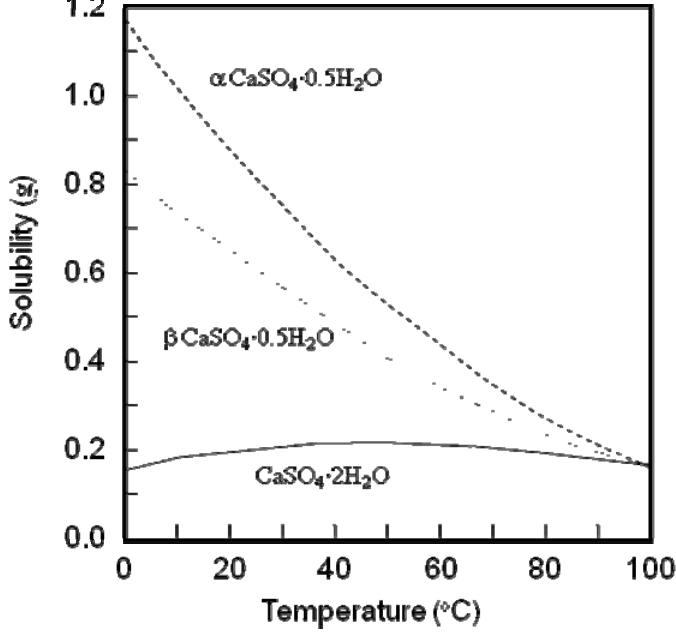
Figure 2. Solubility of α and β calcium sulfate hemihydrate and calcium sulfate dihydrate as a function of temperature